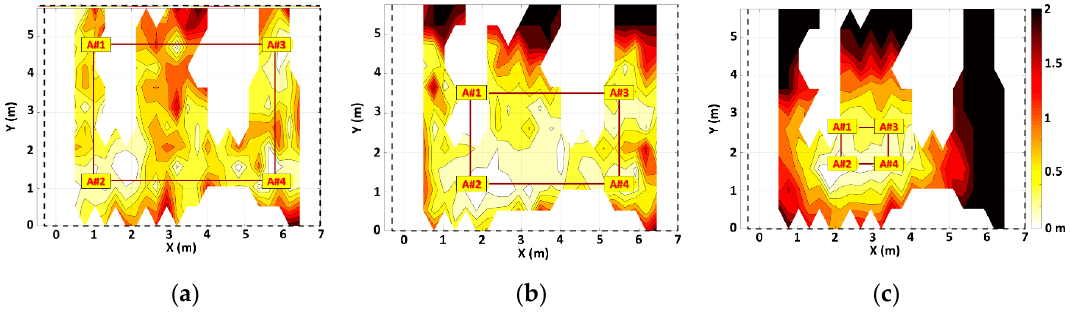
Figure 14. Measured localization error distribution over space for each mesh configuration (white area coincides with inaccessible room space, see Figure 9b), ( a ) large mesh; ( b ) medium mesh; ( c ) tiny mesh.